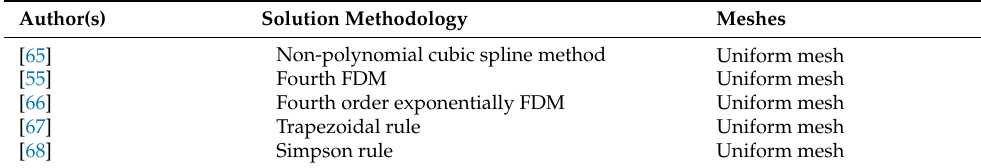
Table 6. Various methods and mesh used to solve Equations (7) and (8).